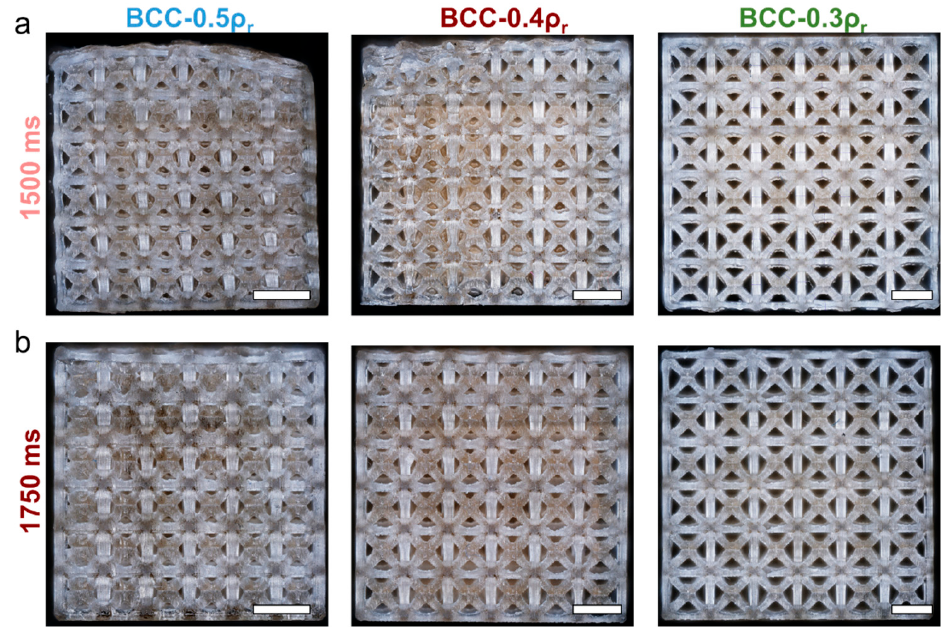
Figure 14. Microscopy of lattice side face for representative samples constructed with ( a ) 1500 ms and ( b ) 1750 ms exposure time per layer. Scale bars approximately 2 mm. and ( b ) 1750 ms exposure time per layer. Scale bars approximately 2